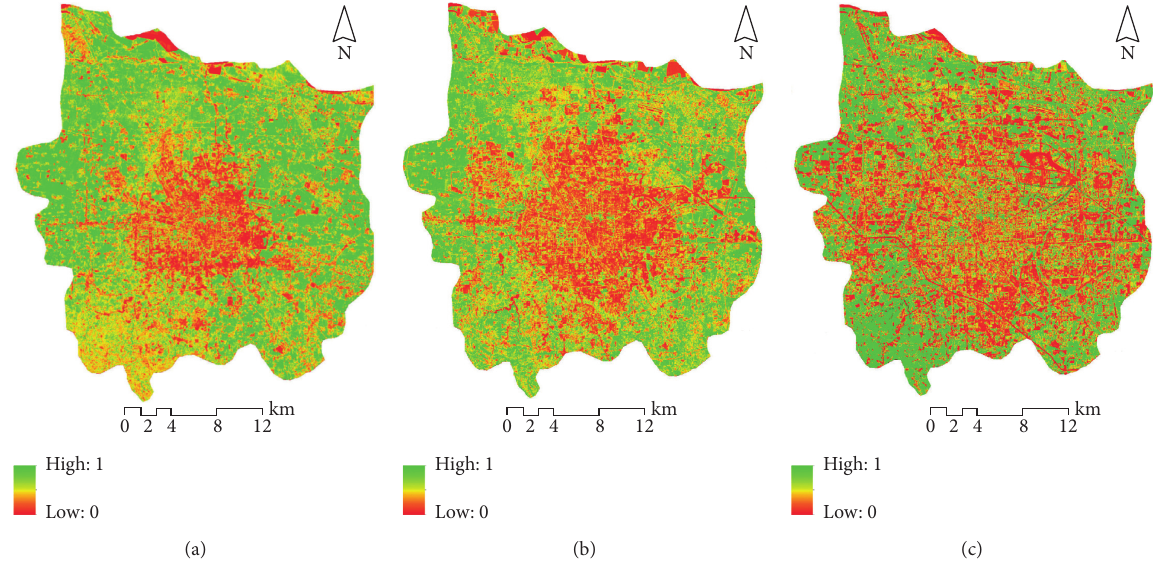
Figure 7: Spatial distribution of FVC from 2000 to 2014. Table 5: Mean and SD zonal FVC derived from different LST